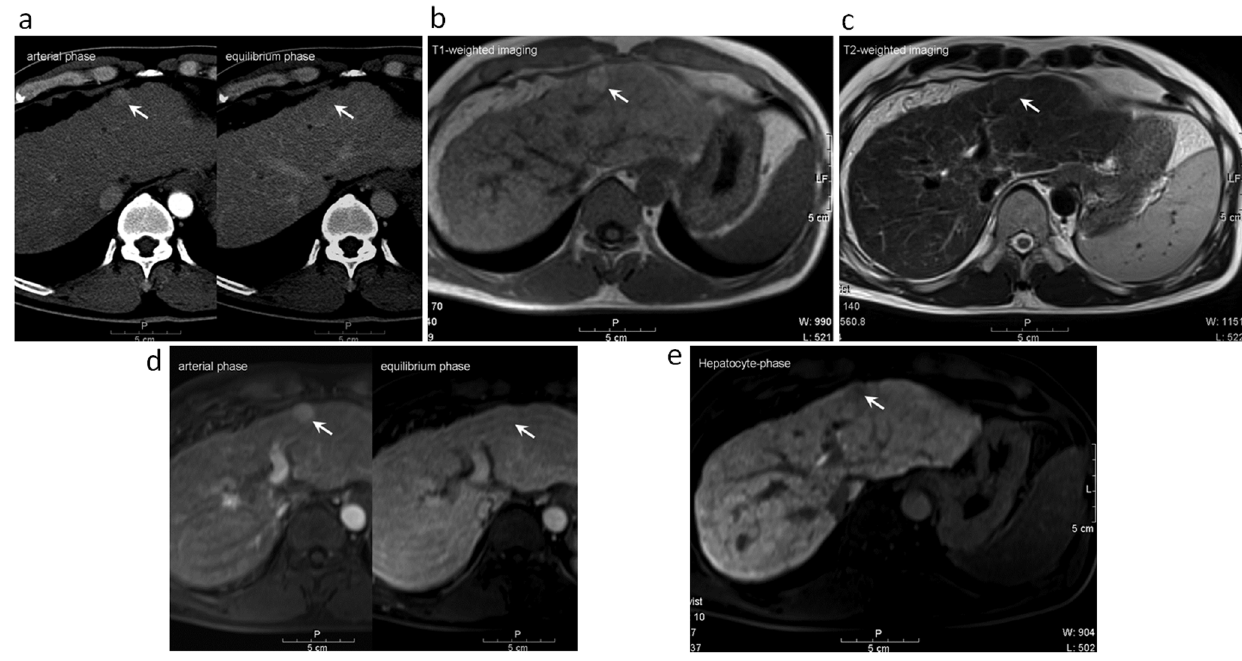
Figure 3. A 59-year-old male with a well-differentiated hepatocellular carcinoma (indicated by arrow) at S3 of the liver underwent gadoxetic acid-enhanced MR imaging and liver biopsy. (a) The tumor depicted hypervascular enhancement in the arterial-phase and isodensity relative to the adjacent liver parenchyma on the equilibrium phase of dynamic CT study. (b) The tumor showed hyperintensity on the T1- weighted image. (c) The tumor showed isointensity on the T2-weighted image. (d) The tumor also showed hypervascular enhancement in the arterial phase image and isointensity relative to adjacent liver parenchyma on equilibrium phases of the dynamic MR study. (e) The tumor showed hypointensity on the gadoxetic acid-enhanced hepatocyte-phase T1-weight image.